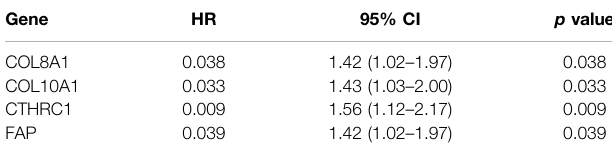
TABLE 1 | Overall survival analysis of Collagen Type VIII Alpha 1 Chain (COL8A1), Collagen Type X Alpha 1 Chain (COL10A1), Collagen Triple Helix Repeat Containing 1 (CTHRC1), and Fibroblast Activation Protein